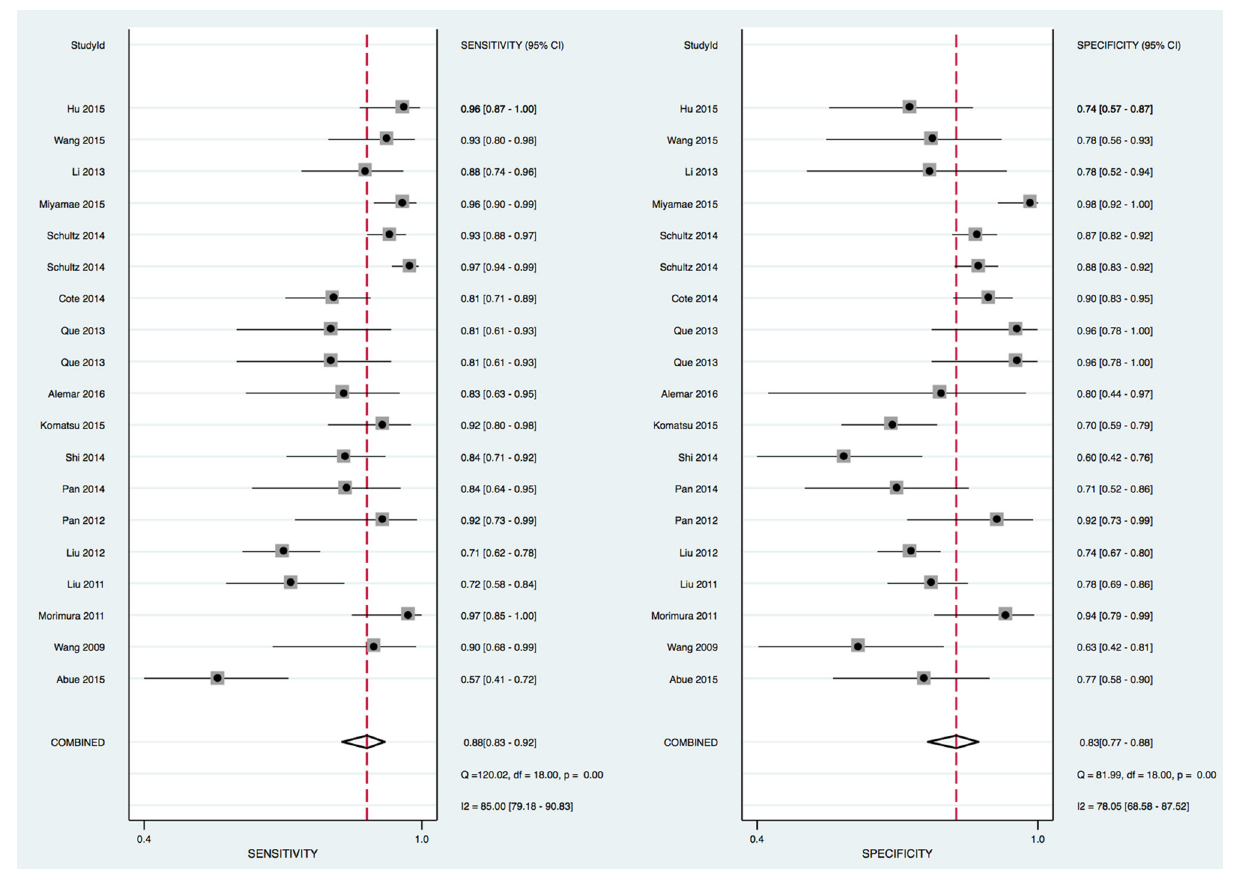
FIGURE 2 | Forrest plot of estimates of sensitivity and